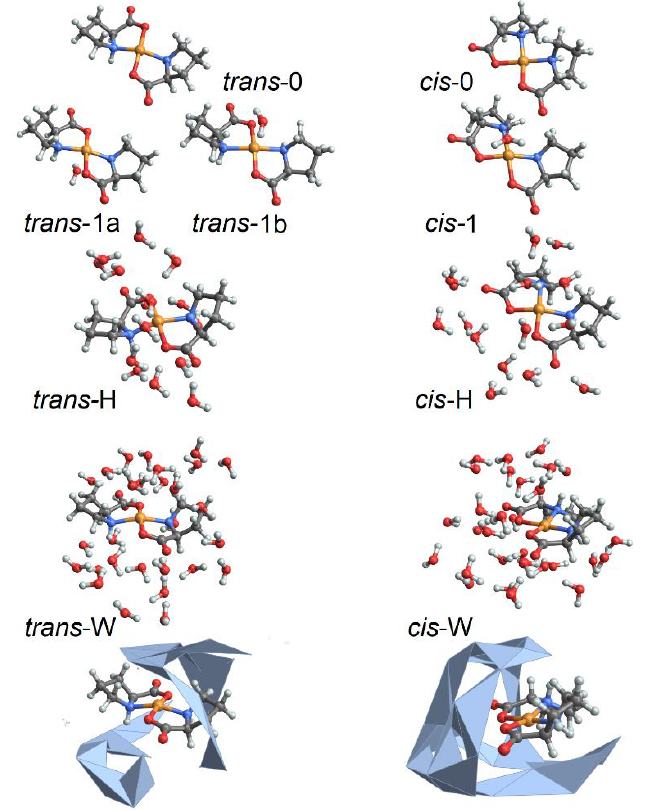
Figure 1. Selected model systems for BOMD studies: without water, structures cis -0 and trans -0; with 15 water molecules: structural cases cis -H and trans -H; and with 29 water molecules: structural cases cis -W and trans -W. Here, to stress the difference in character of water packing next to the complex under the two geometries, we image water in cis -W and trans -W structures combining wireframe and convex hull formats.